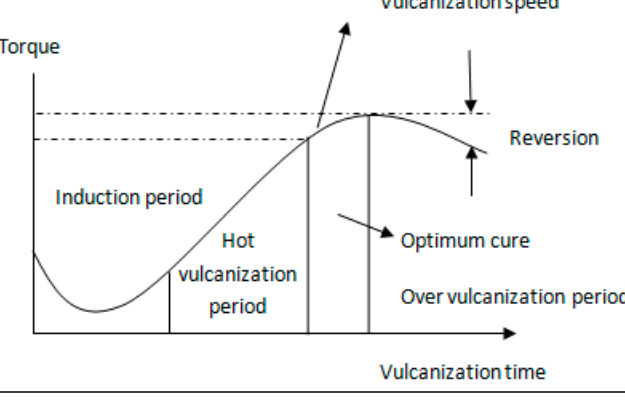
Figure 2. Vulcanization reaction process [24].